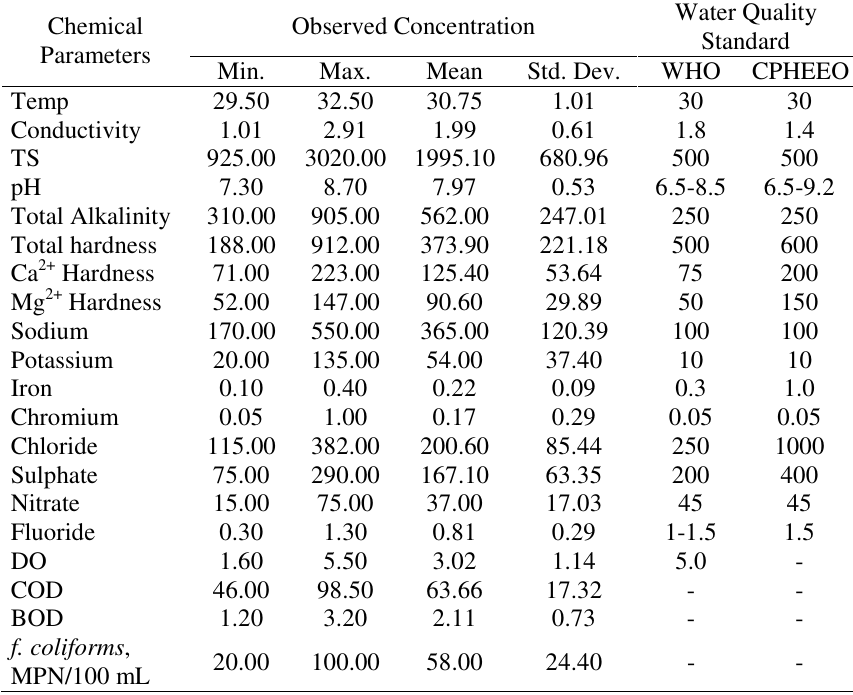
Table 4. The minimum, maximum, average concentration and standard deviation of chemical parameter with water quality